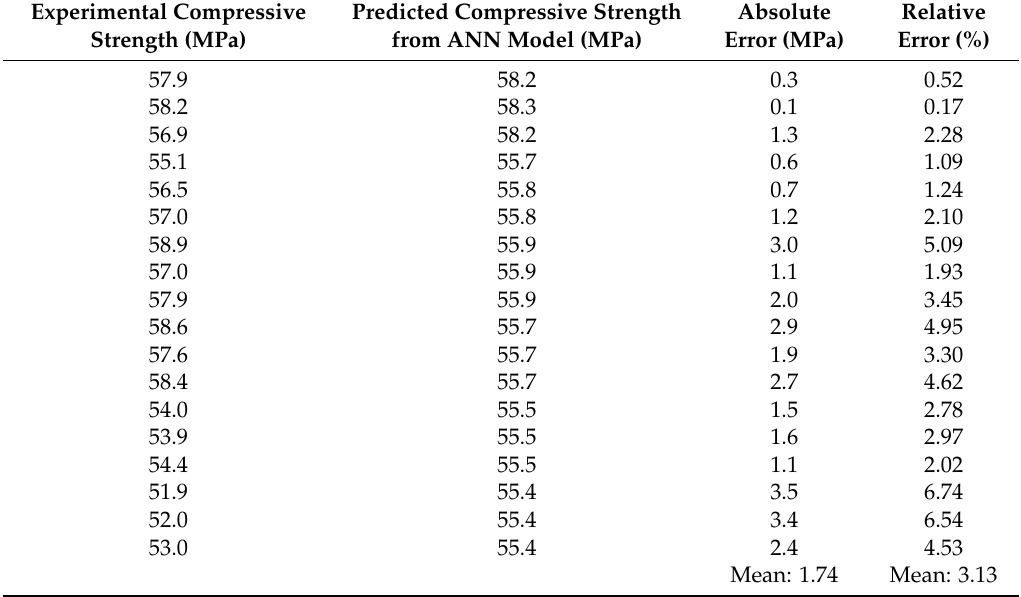
Table 7. Comparison of the predicted and experimental compressive strengths in the testing phase. Experimental Compressive Predicted Compressive Strength Strength (MPa) from ANN Model